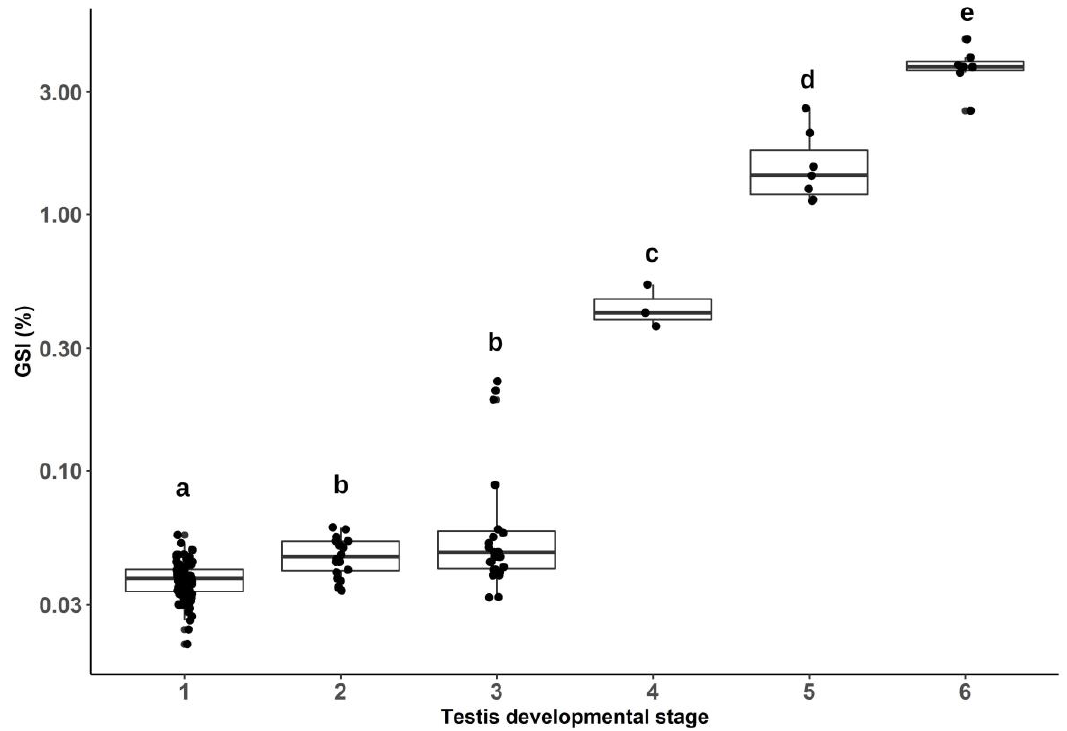
Figure 2. Boxplots of the gonadosomatic index (GSI) for each testis developmental stage. Each of the boxplots includes a scatter plot to display the number of samples included and their GSI values. Significant differences in GSI between developmental stages were assessed with a Kruskal – Wallis test, followed by pairwise comparisons with a Wilcoxon rank sum test with continuity correction. Different letters indicate significant differences in mean GSI ( p < 0.05).